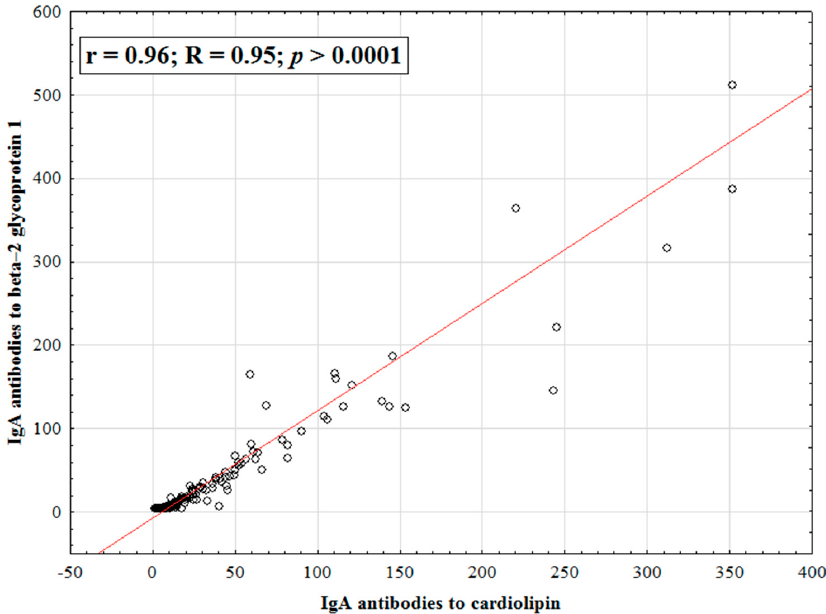
Figure 5. Correlation of IgA antibodies to beta-2 glycoprotein 1 with IgA antibodies to cardiolipin. Note: r-Pearson correlation coefficient, R-Spearman correlation coefficient, and p -reliability.